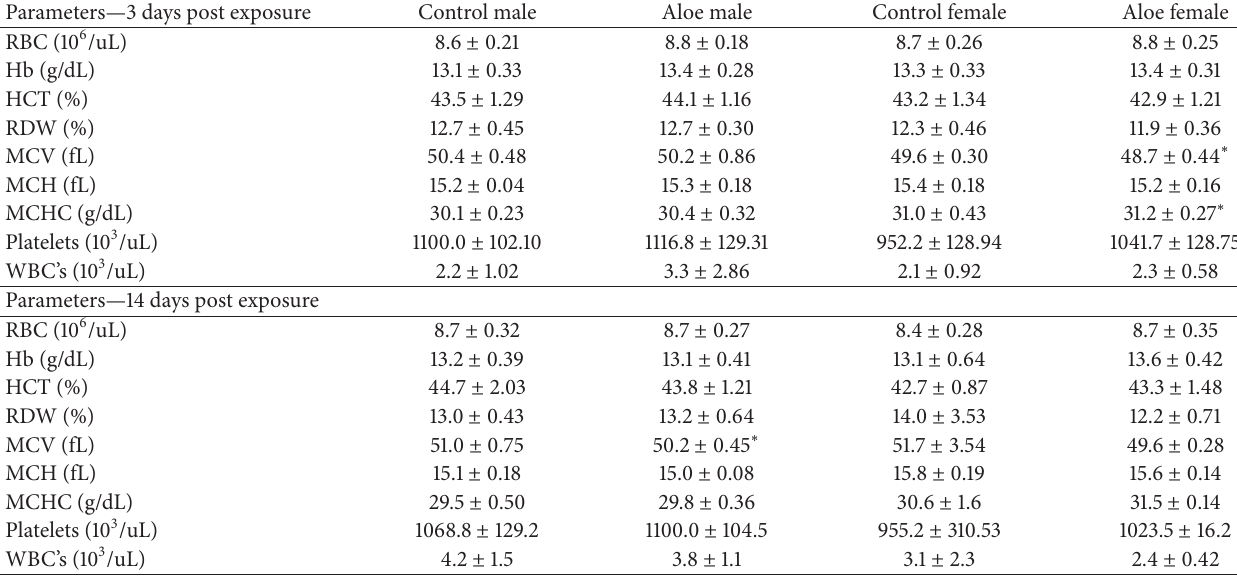
Table 3: Hematology of whole blood from B6C3F1 mice administered aloe juice by